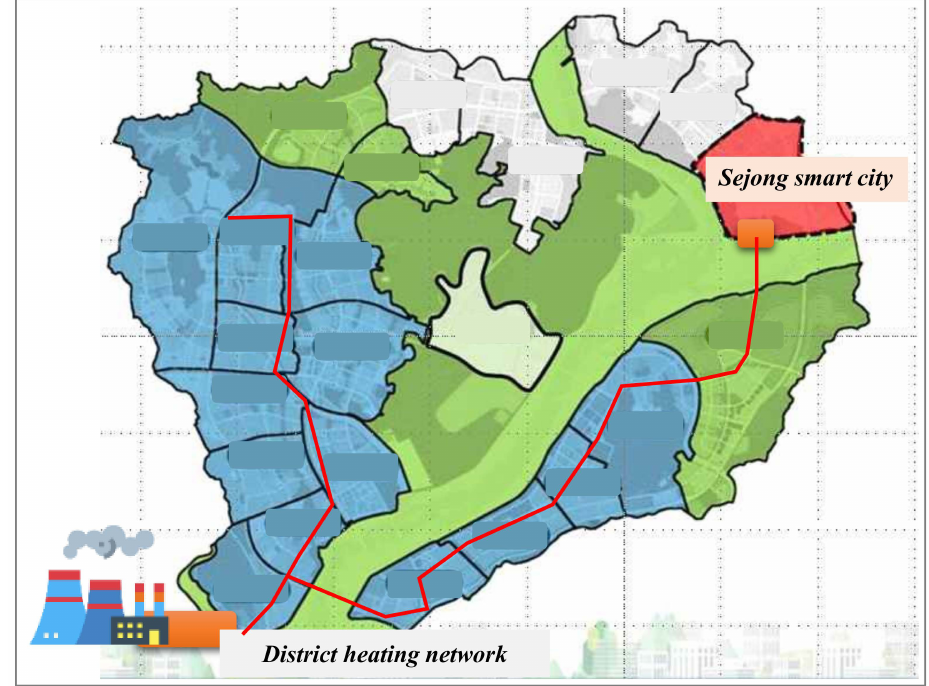
Figure 2. Location of Sejong national pilot smart city and thermal network.